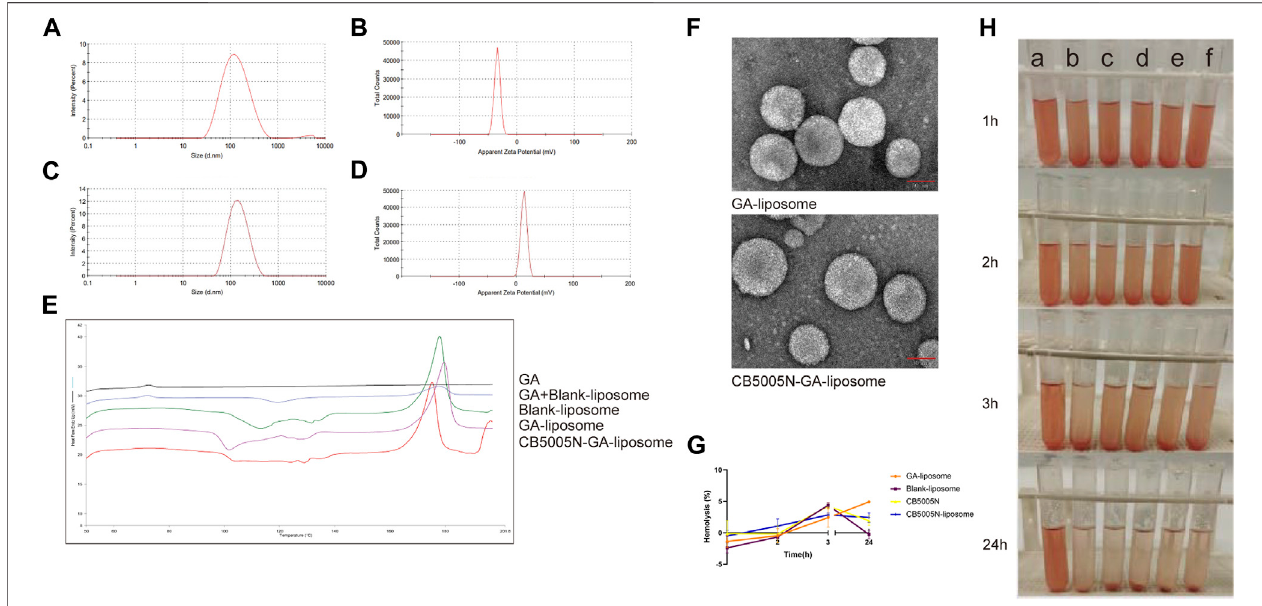
FIGURE 1 | (A – D) Characteristics of GA-liposome and CB5005N-GA-liposome. (E) DSC of different preparations. (F) The TEM photos of GA-liposome and CB5005N-GA-liposome (scale bar = 50 nm). (G) Hemolysis (%). (H) Hemolysis assays (a: deionized water, b: saline, c: Blank-liposome, d: GA-liposome, e: CB5005N- liposome, f: